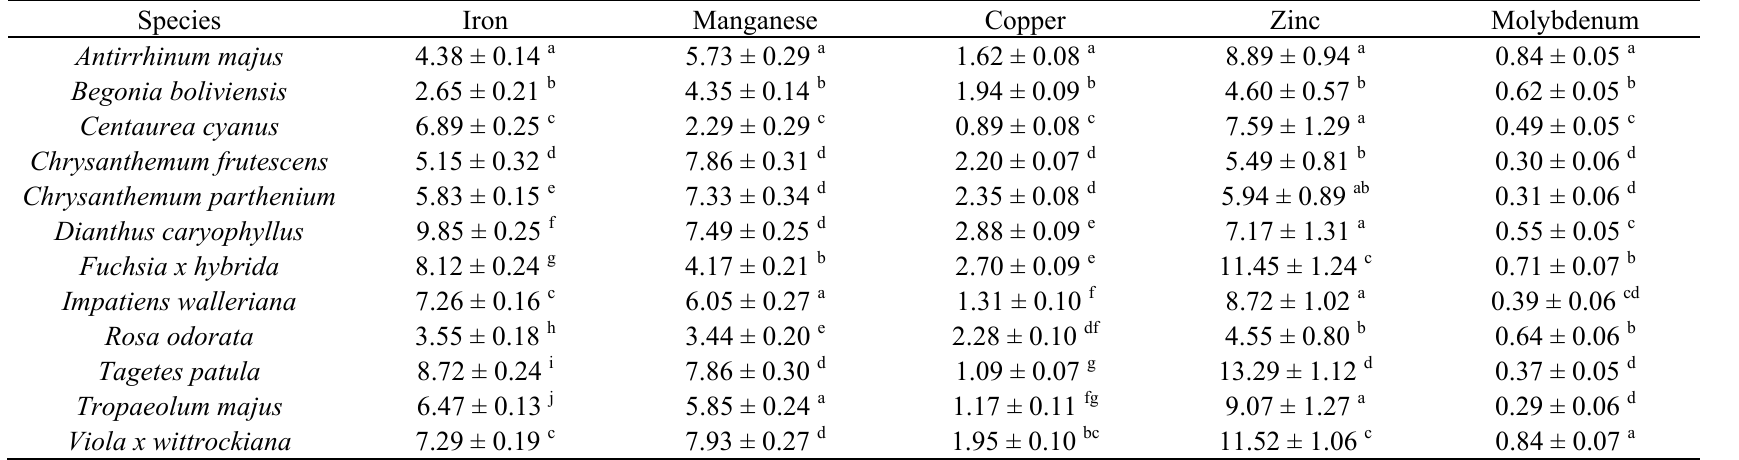
Table 4. Content of microelements (mg/kg of FM) in 12 species of edible flowers, n = 10.